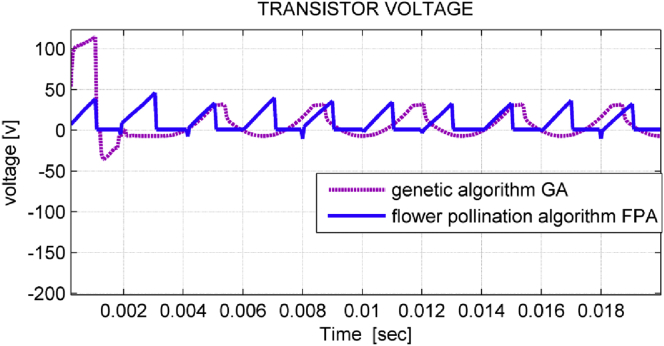
Transistor voltages.